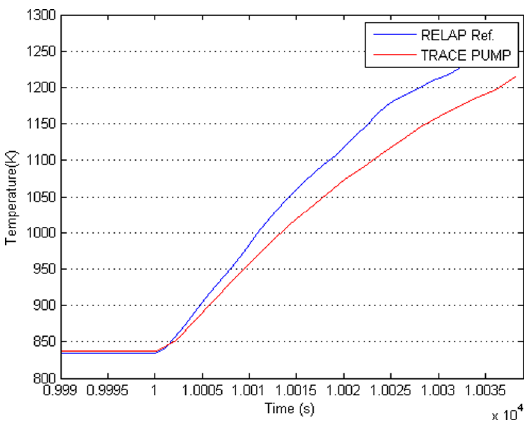
Fig. 8. HFA sodium